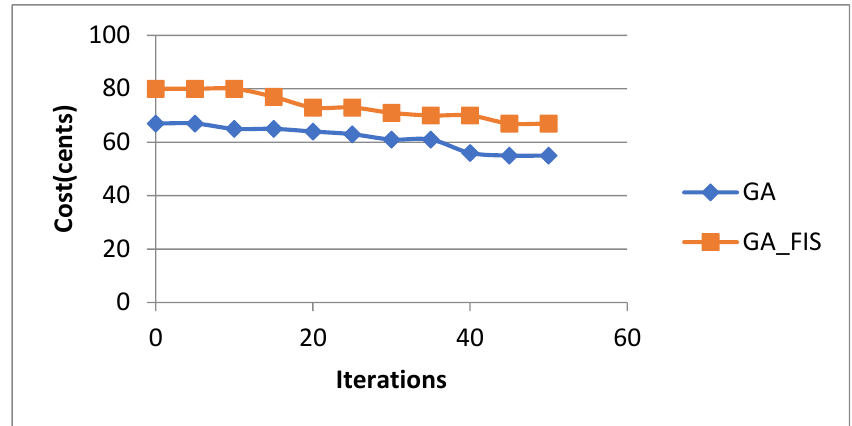
Figure 22. Fitness evolution graphs of GA_FIS and GA for smart load 2.